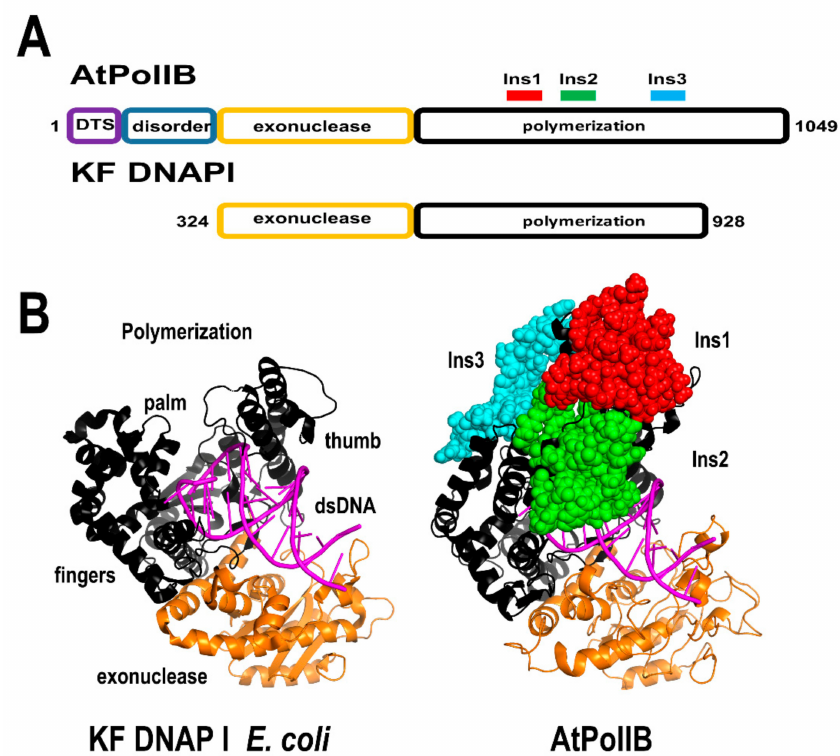
Figure 9. Structural comparison between AtPolIB and bacterial DNAPs. ( A ) Domain organization of both DNAPs. The polymerization domains are colored in black and the 3 (cid:48) -5 (cid:48) exonuclease domains in orange. The unique amino acid insertions in AtPolIB in comparison to bacterial DNAPs I are depicted in a ball-stick representation and colored in red, green, and cyan. AtPolIs contain an N-terminal DTS and a disorder region not present in the structural model. ( B ) homology model of AtPolIBs with the crystal structures of the Klenow fragment from E. coli DNAP I. In both models, the dsDNA from Bacillus DNAP I is